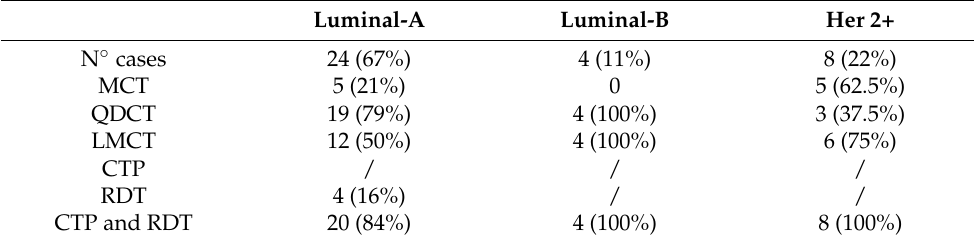
Table 2. Therapy performed in relation to the cancer histological